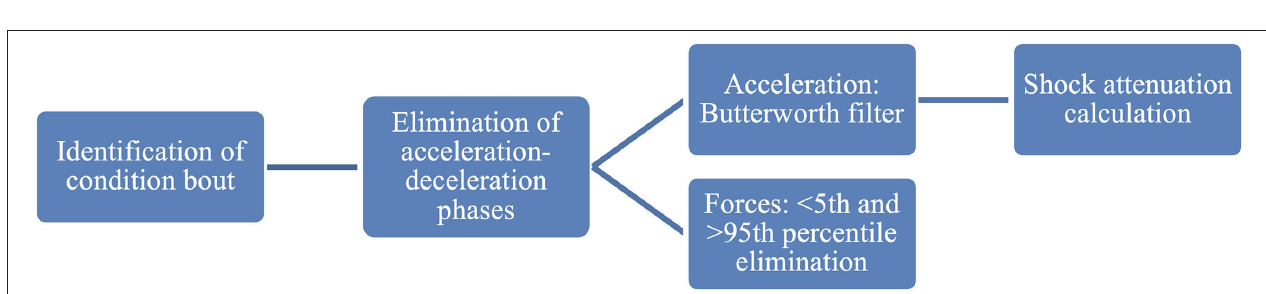
FIGURE 4 | Data processing